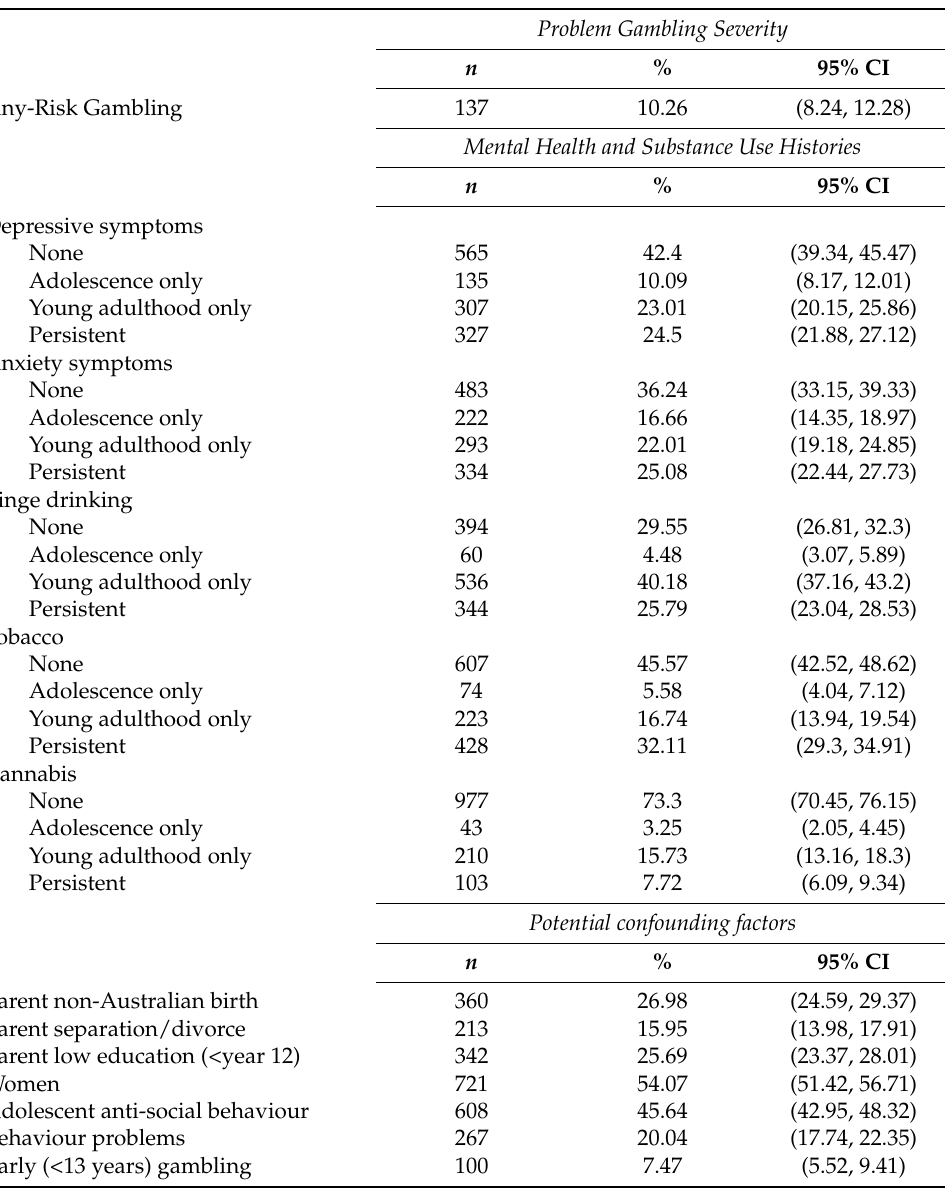
Table 1. Descriptive statistics (pooled) for analytic variables ( n =